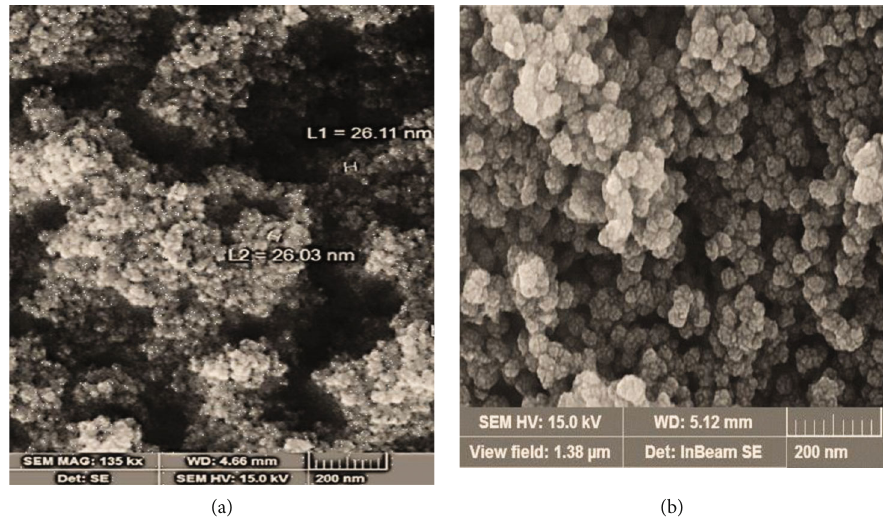
Figure 3: SEM micrograph of Fe